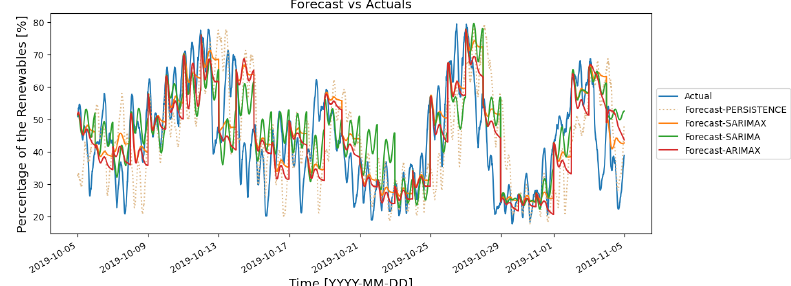
Figure 4. Forecasts for a one month period in summer 2019.